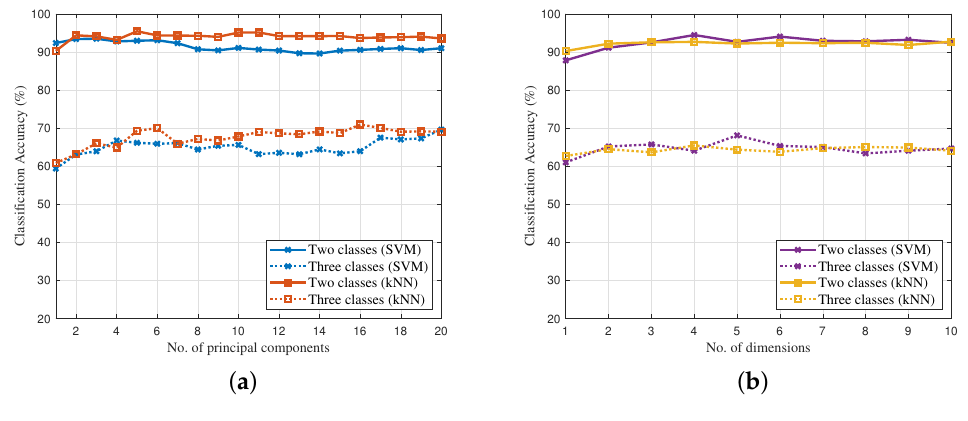
Figure 9. Comparison of classification accuracy achieved by SVM and kNN considering 2 and 3 classes, applying ( a ) Principal Component Analysis (PCA) and ( b ) t-distributed stochastic neighbor embedding (t-SNE).